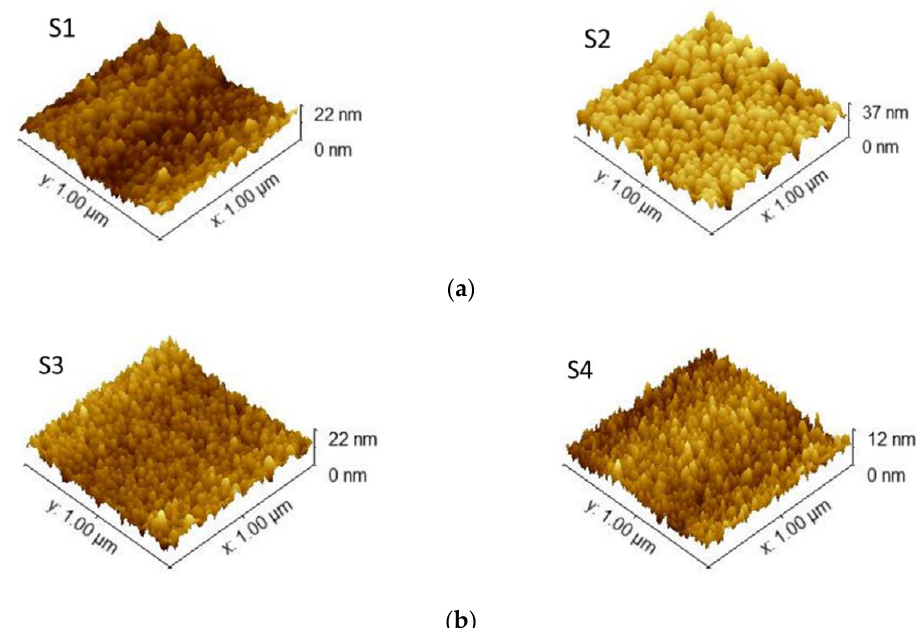
Figure 3. Three-dimensional micrographs ( 1 × 1 µm 2 ) of the Cu 3 N films deposited in ( a ) N 2 + Ar mixture and ( b ) pure N 2 environments.